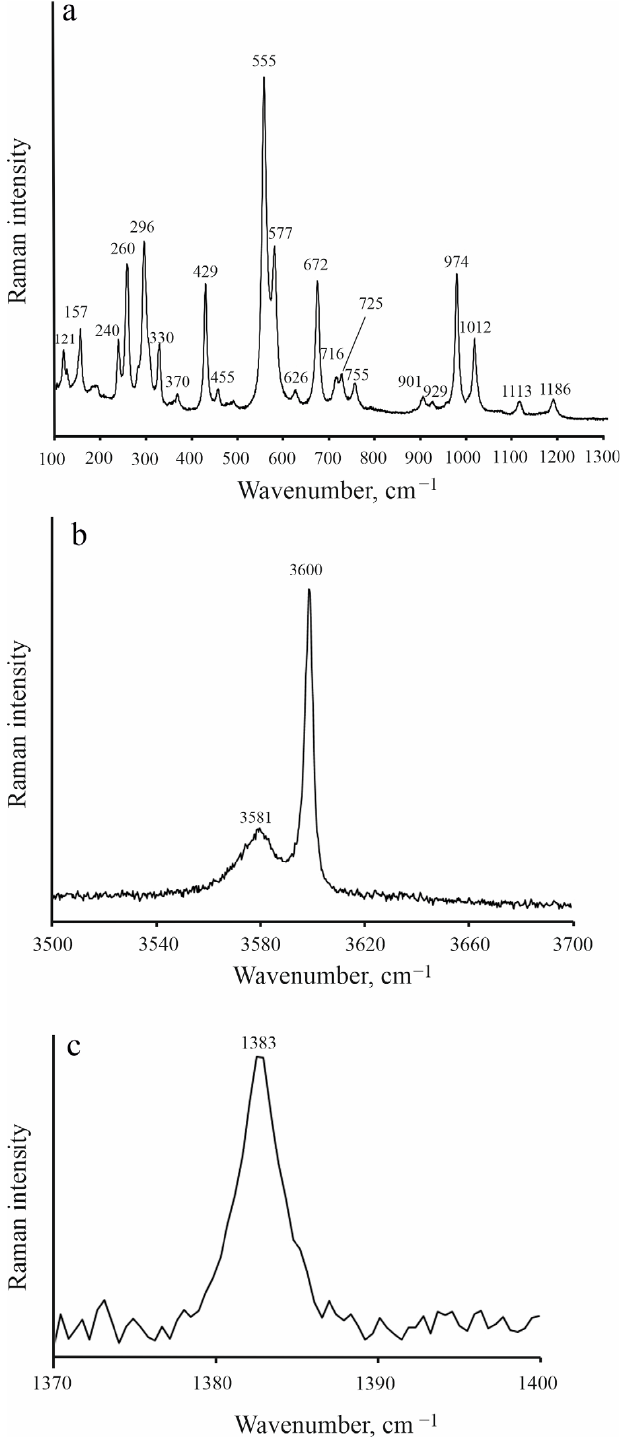
Figure 3. Raman spectra of ( a ) cordierite (host mineral), ( b ) single water molecules (Raman lines 3581 and 3600 cm − 1 ), and ( c ) carbon dioxide (Raman line 1383 cm − 1 ) isolated in crystal cavities, from the Muzkol metamorphic complex, Tajikistan.